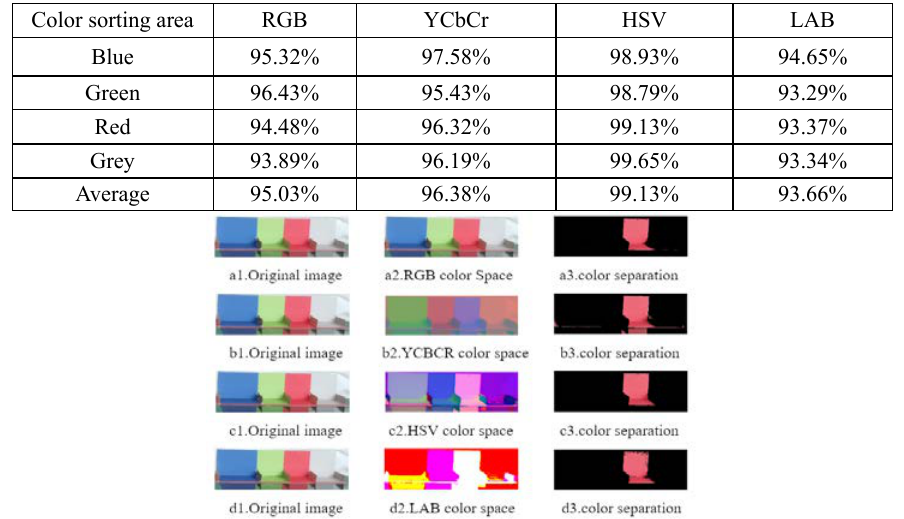
Table 1. Color separation values in different color spaces.